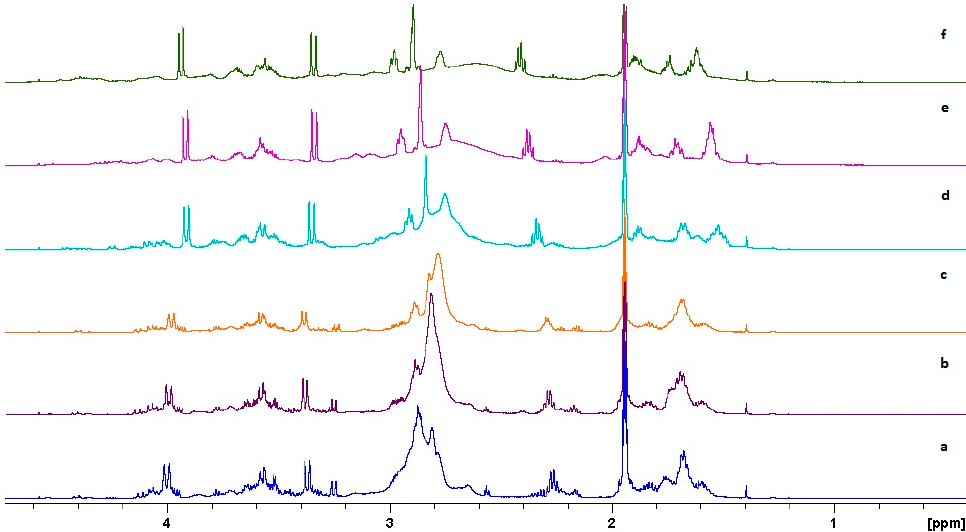
Figure 3. The 1 H-NMR spectra in acetonitrile solutions for uncomplexed ligand L-spectrum ( a ) and after adding silver ions with the Ag:L molar ratio 0.5:1, 1:1, 2:1, 3:1 and 4:1-spectra ( b ), ( c ), ( d ), ( e ), and ( f ), respectively.